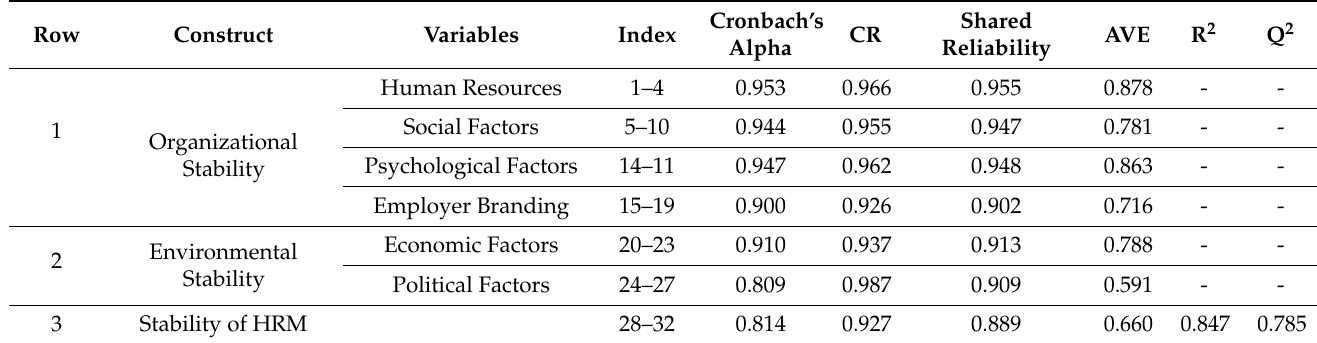
Table 1. Composite reliability, Cronbach’s alpha, AVE (Source: